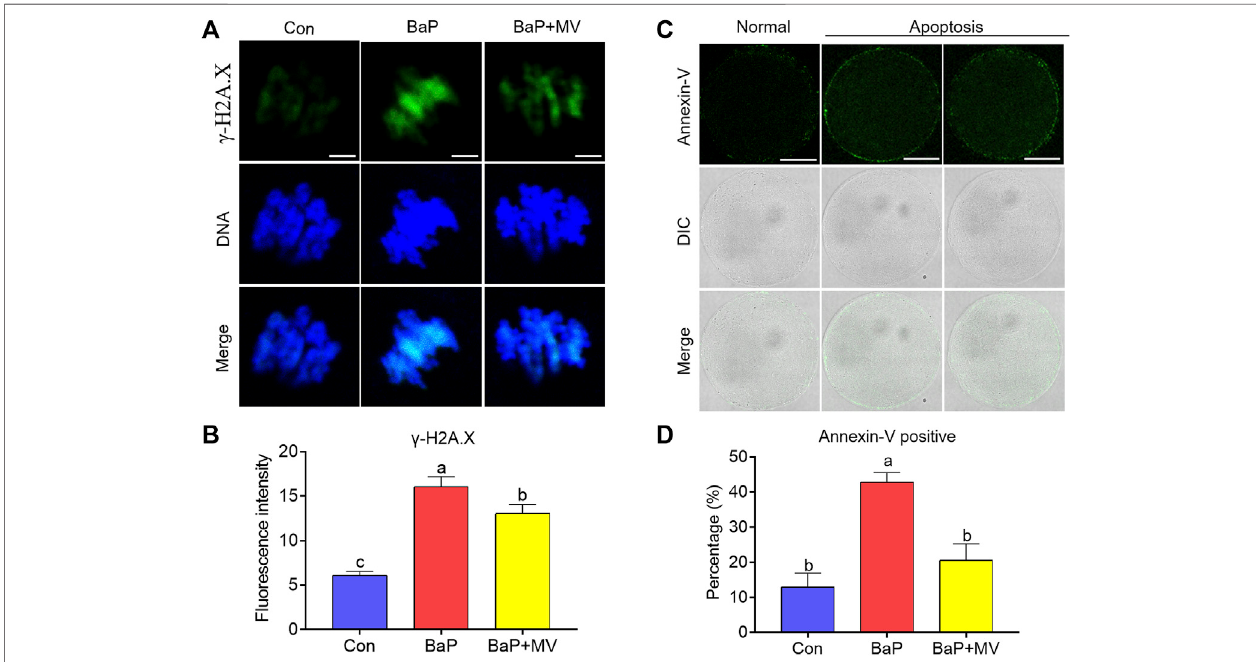
FIGURE6| EffectsofMVonDNAdamageandapoptosisintheoocytesofBaP-exposedmice.DNAdamageandearlyapoptosisintheoocytesweremeasuredby stainingwith γ -H2A.XandAnnexin-Vprobe,respectively. (A) RepresentativeimagesofDNAdamageinCon,BaPandBaP+MVoocytes. (B) The fl uorescenceintensity of DNA damage in the Con, BaP and BaP + MV groups. Scale bar (cid:2) 5 μ m. (C) Representative images of apoptosis in Con, BaP and BaP + MV oocytes. (D) The fl uorescence intensity ofapoptosis intheCon, BaPand BaP+MVgroups. Scalebar (cid:2) 50 μ m. Thedataarepresentedasthemean ± SEM. a-c Means notsharing a common superscript are signi fi cantly different ( p <